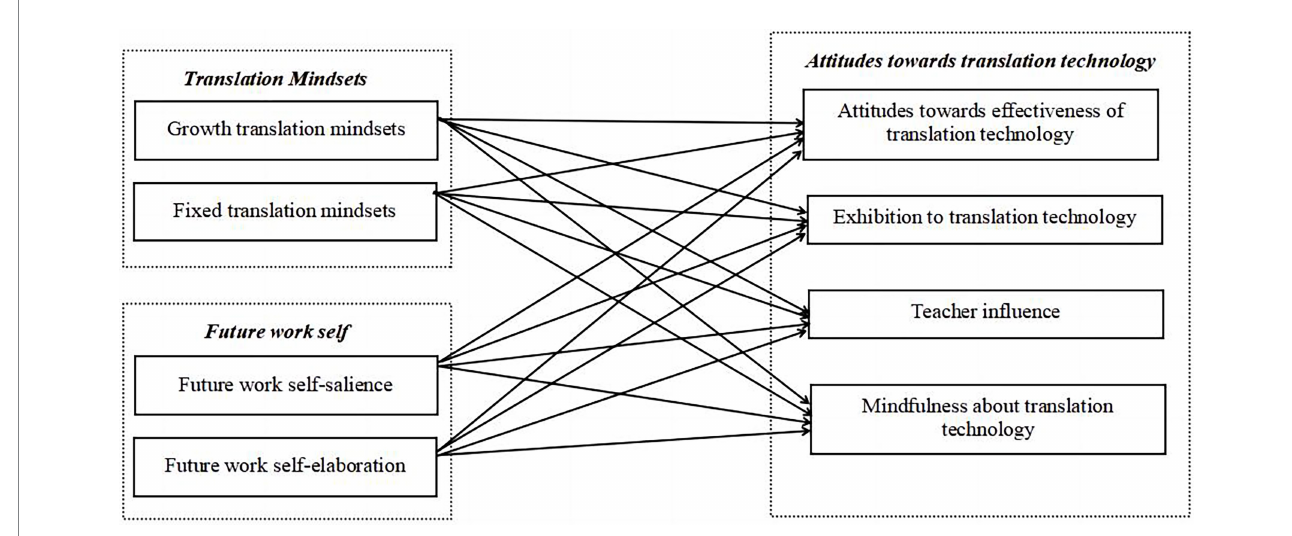
FIGURE 1 Hypothesized research model for